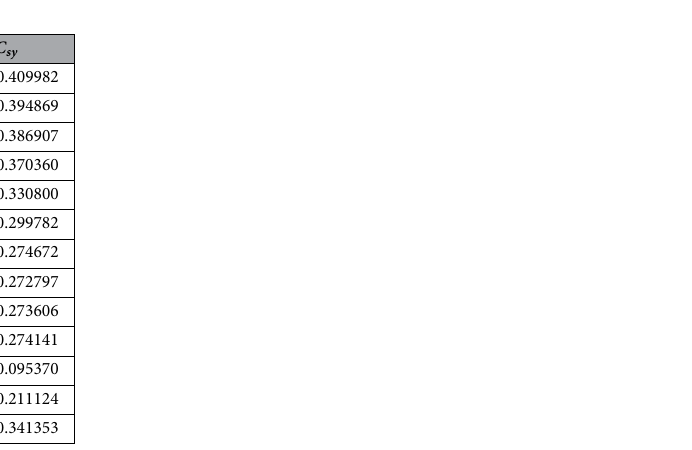
Table 4. Impacts of the embedded parameters on C sx and C sy